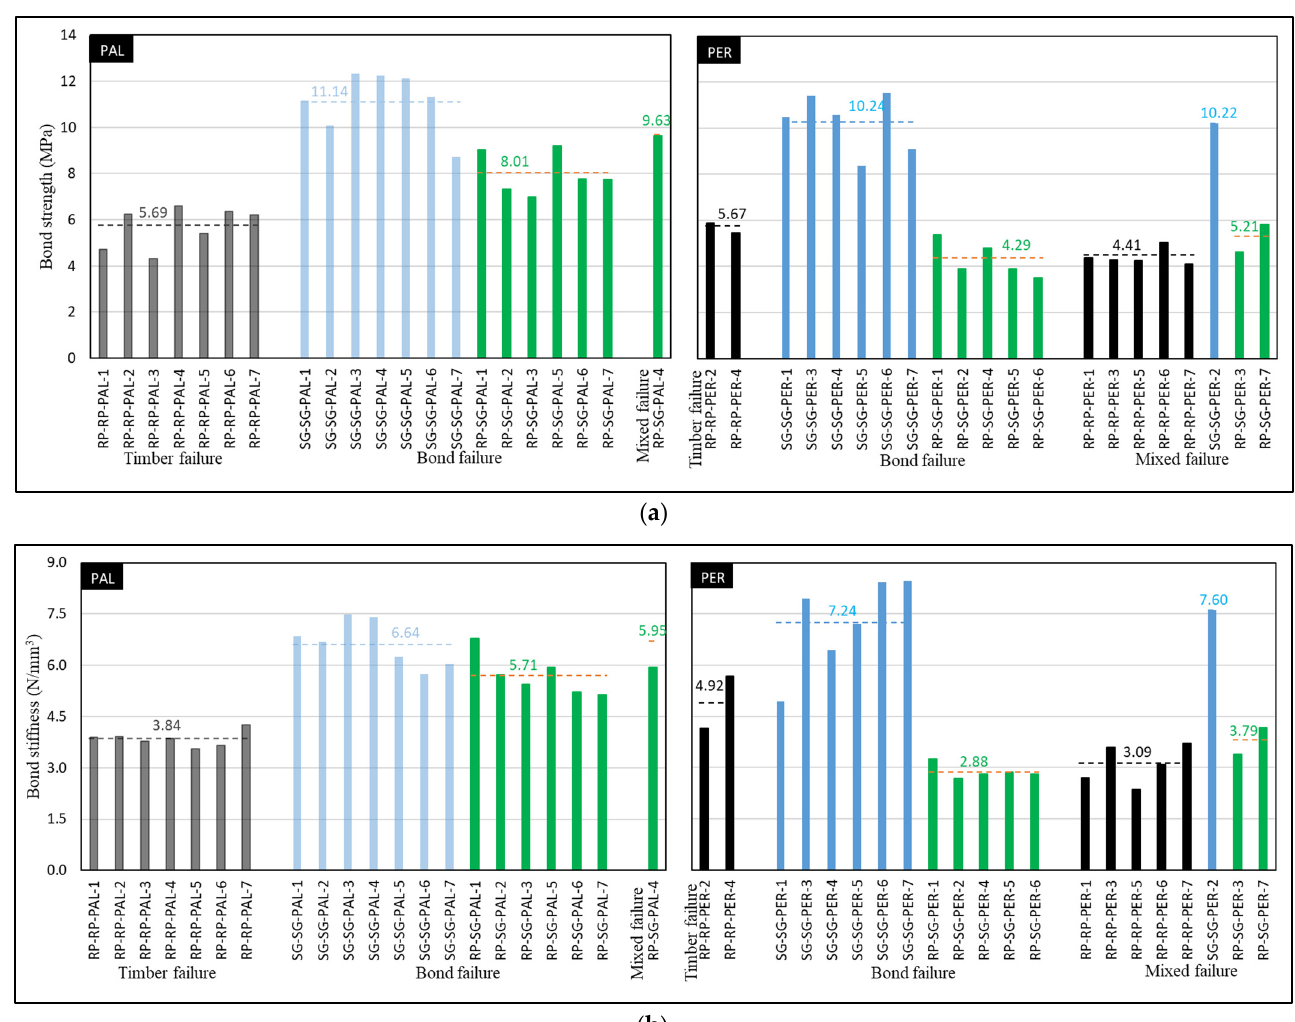
Figure 9. Bond characteristics regarding failure modes. ( a ) Shear bond strength, ( b ) shear bond sti ff - ness.